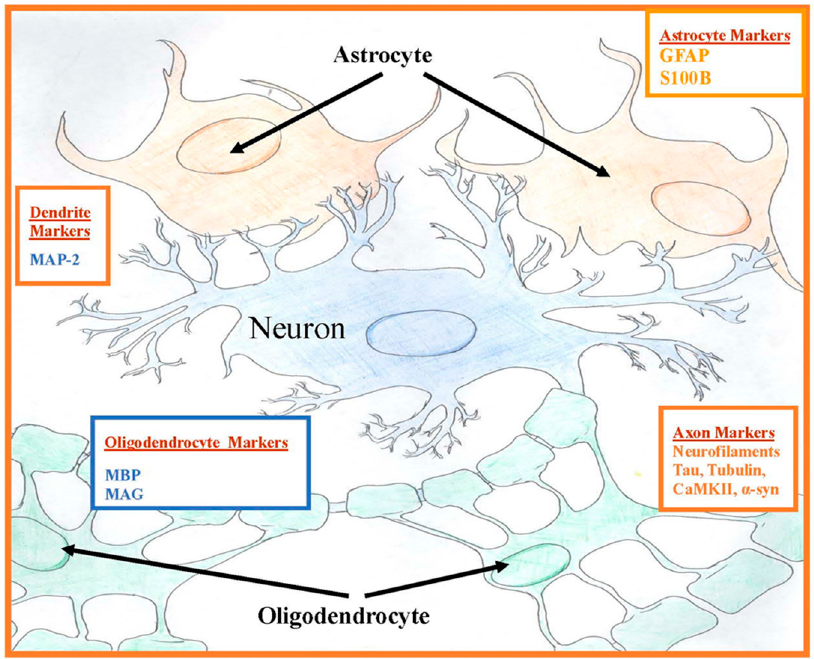
Figure 1. Central nervous system protein locations of plasma autoantibodies. Oligodendrocytes myelinate inside the central nervous system (CNS) and Schwann cells myelinate outside of the CNS.